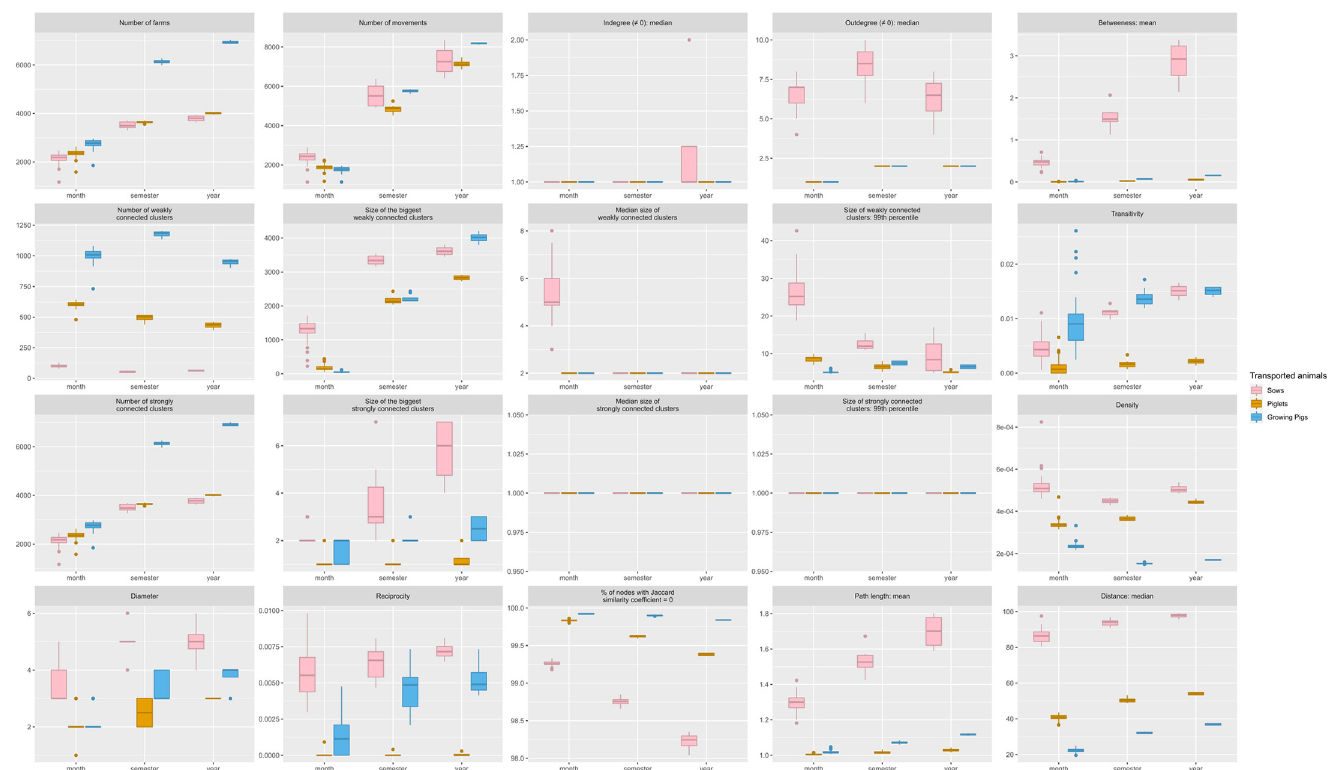
Fig 4. Network centralities per type of transported animals. Average network centralities per month, semester and year for the networks respectively built from the transport of sows, piglets and growing pigs.